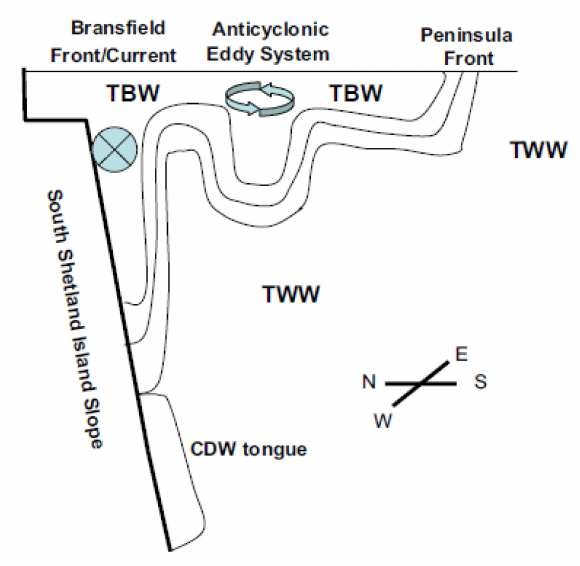
Figure 6. Cross-sectional diagram of the main components of the Bransfield Strait current system